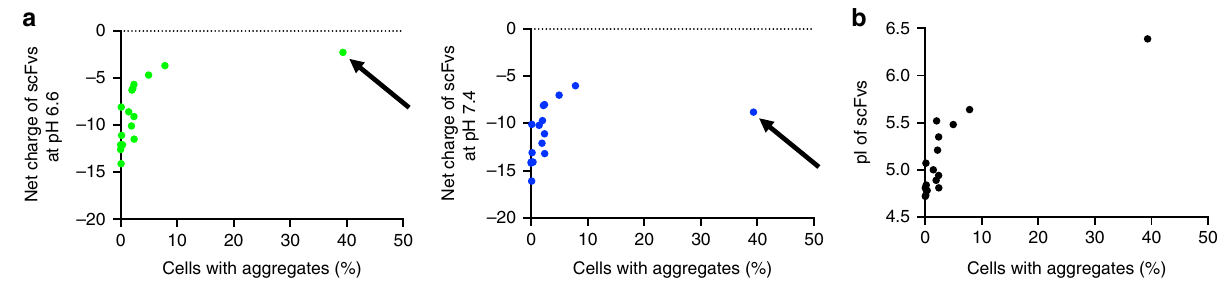
Fig. 2 Correlated aggregation rate and net negative charge of scFvs at pH 6.6. a An additional 15 s3Flag-scFv-HA proteins derived from scFvs in supplementary Fig. 2 were constructed, and their aggregation rate in HeLa cells was quanti fi ed using immunocytochemical analysis. Statistical correlation analysis of the net negative charge and aggregation rate of 16 s3Flag-scFv-HA proteins including s3Flag-scFv-A36-HA, and scFv-GFPA36 in HeLa cells (17 scFvs were tested) (left, net negative charge at pH 6.6 vs. aggregation rate: r = 0.6168, P = 0.008179; right, net negative charge at pH 7.4 vs. aggregation rate: r = 0.3709, P = 0.1427). The arrow in left panel (pH 6.6) indicates a net charge value of scFv-GFPA36, which is shifted to a higher absolute value of the negative charge in the right panel (pH 7.4), owing to its relatively high pI. The success rate of stable expression (less than around 2% aggregation) of s3Flag-scFv-HA proteins (16 total proteins) was found to be ~82%. b Statistical correlation analysis of pIs and aggregation rates of 17